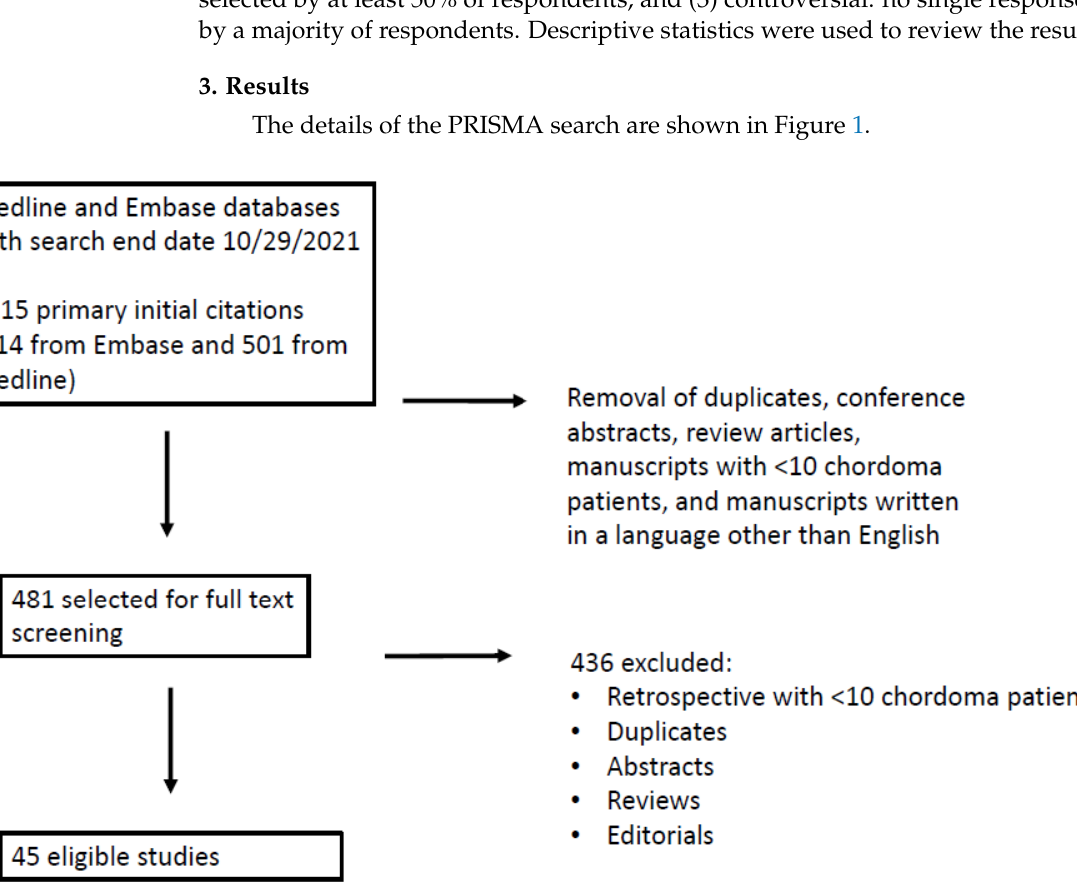
Figure 1. details of the PRISMA